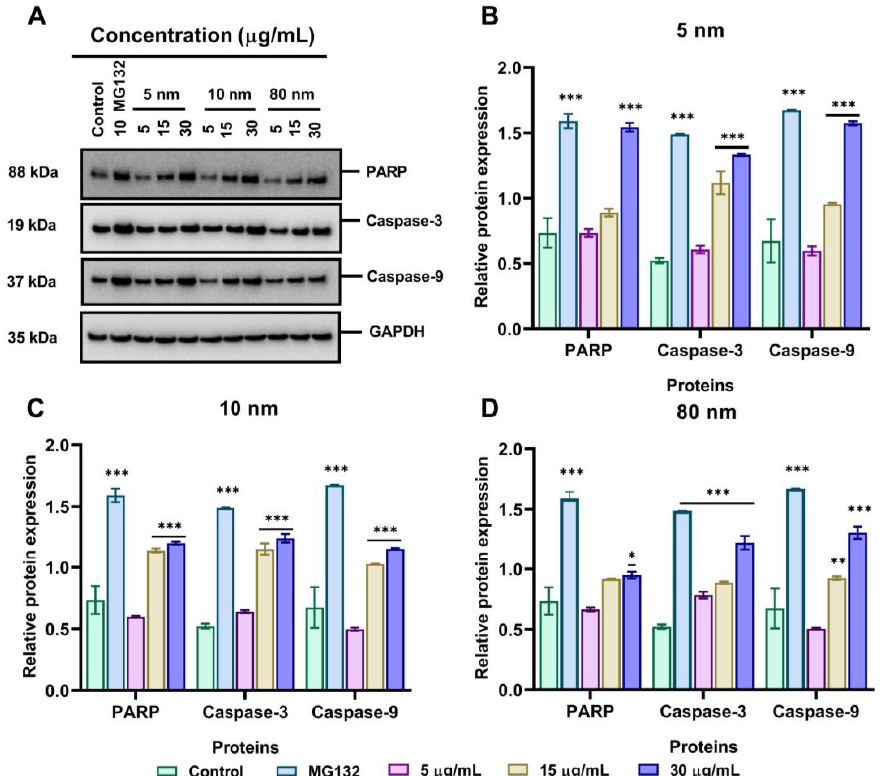
Figure 8. AuNPs induced apoptosis in A549 cells through a mitochondrial signalling pathway. ( A ) The expression of apoptosis-related protein levels detected by Western blot after A549 cells were incubated with 5, 15, and 30 µg/mL of different sizes of AuNPs for 24 h. MG132 (10 µg/m) was used as a positive control. The relative expression signal intensity of apoptosis-related proteins semi-quantified by ImageJ software for ( B ) 5 nm, ( C ) 10 nm, and ( D ) 80 nm AuNPs. Plotted graphs represent the means ± SD of three independent experiments. Bars with an asterisk (*) show a statistical difference (* p < 0.05, ** p < 0.01, *** p < 0.001) when compared with the control.